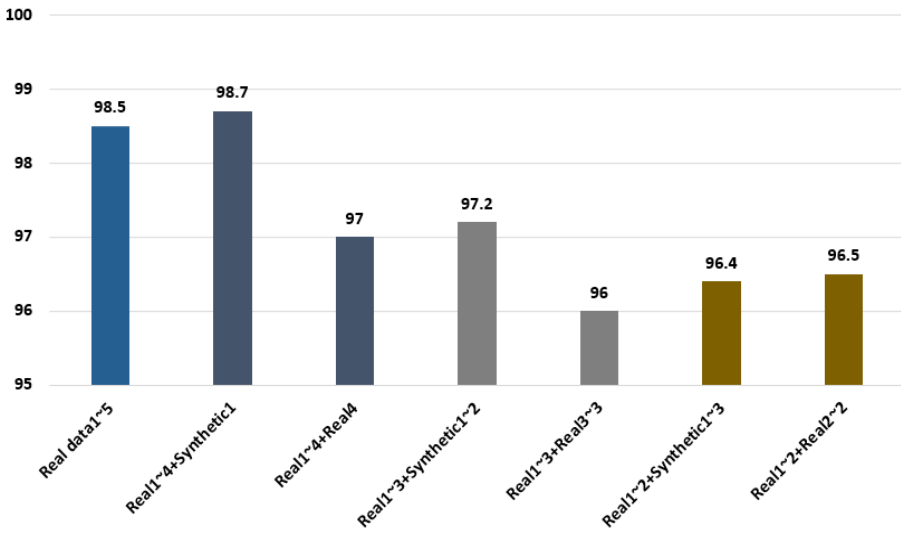
Figure 9. Comparison of recognition performance using the real and synthetic ECG signals.